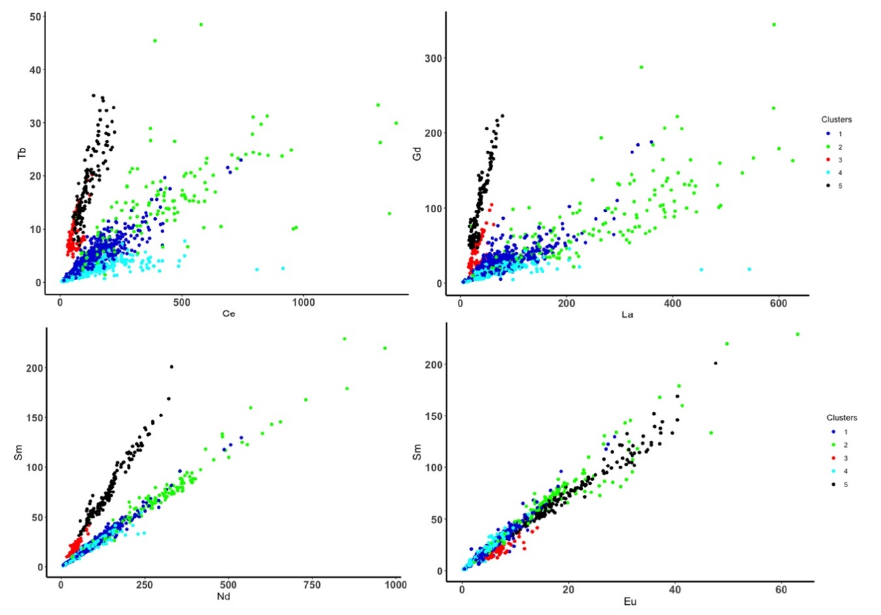
Figure 9. Examples of element ratios distinguishing clusters C1 and C2 from the rest of the samples. Numbers: clusters of the HAC. Minerals 2020 , 10 , x FOR PEER REVIEW